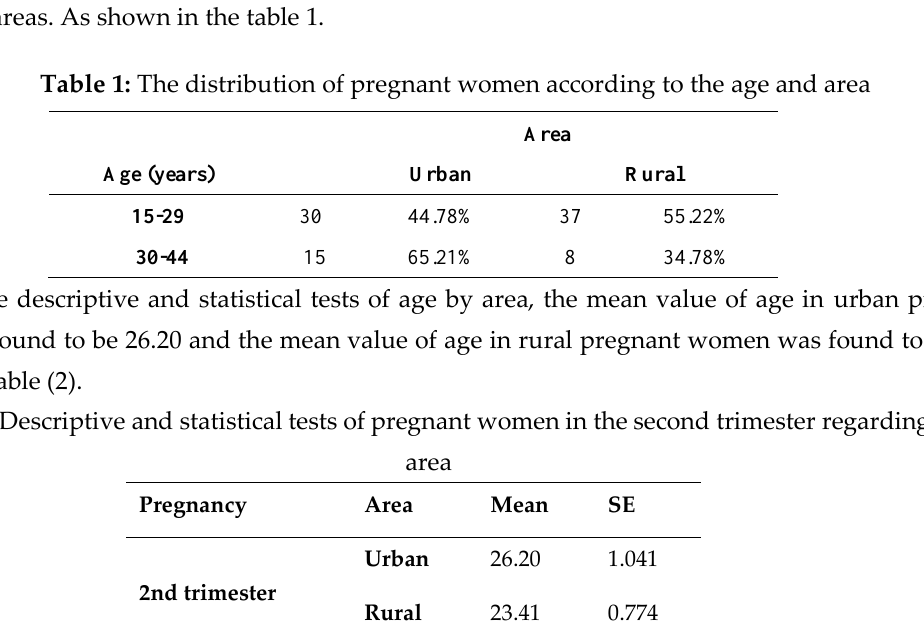
Table 1: The distribution of pregnant women according to the age and area